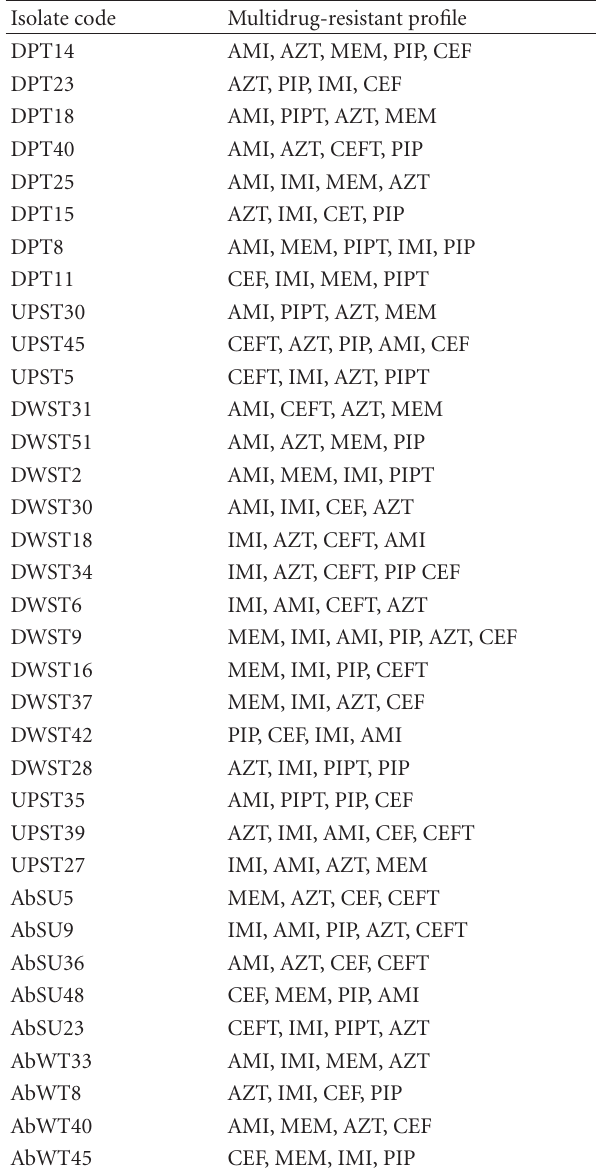
Table 2: Multidrug-resistant (MDR) pattern of P.